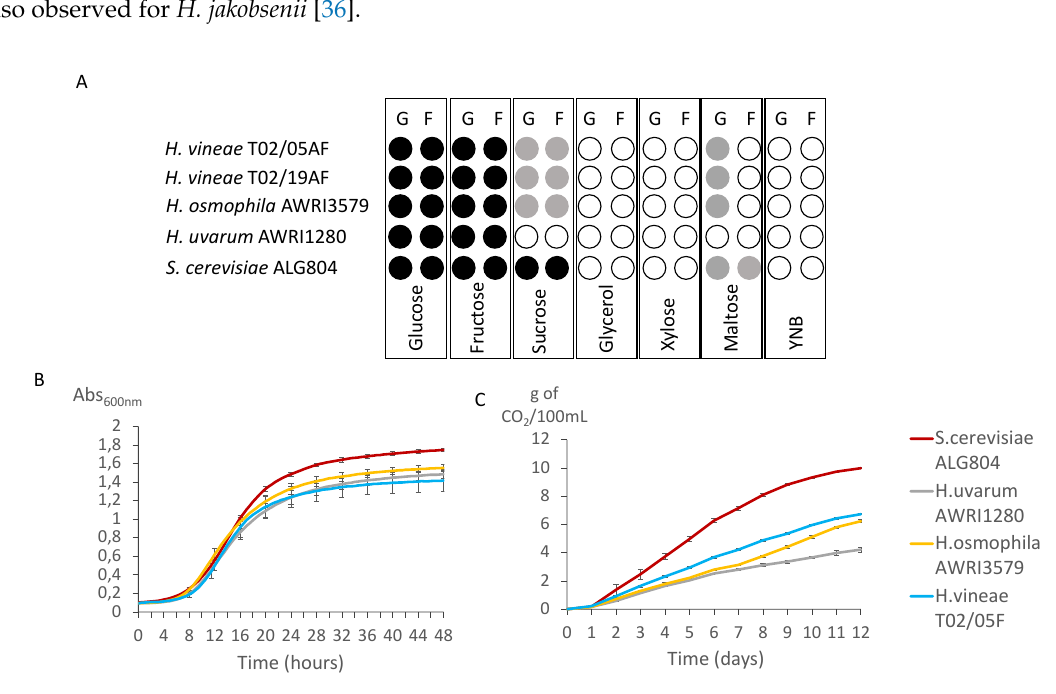
Figure 1. Capacity of Hanseniaspora vineae and Saccharomyces cerevisiae to grow and ferment under varied conditions. ( A ) Growth of H. vineae and S. cerevisiae (G) and the capacity of the species ferment (F) when six different carbon sources (2% w/w) were provided. Yeast nitrogen base (YNB) that lacked a carbohydrate was used as a negative control. Black filled circles indicate that full growth and fermentation were observed, grey circles indicate the moderate capacity of species to grow and ferment, and white circles indicate that the species was not able to grow or ferment. ( B ) Growth kinetics of Hanseniaspora spp. and S. cerevisiae on the Chardonnay grape juice measure as increased absorbance over a period of 48 h. ( C ) Fermentation kinetics of the three strains in the Chardonnay grape juice after 12 days are shown. Growth and fermentation experiments were performed using independent triplicate samples and error bars express standard